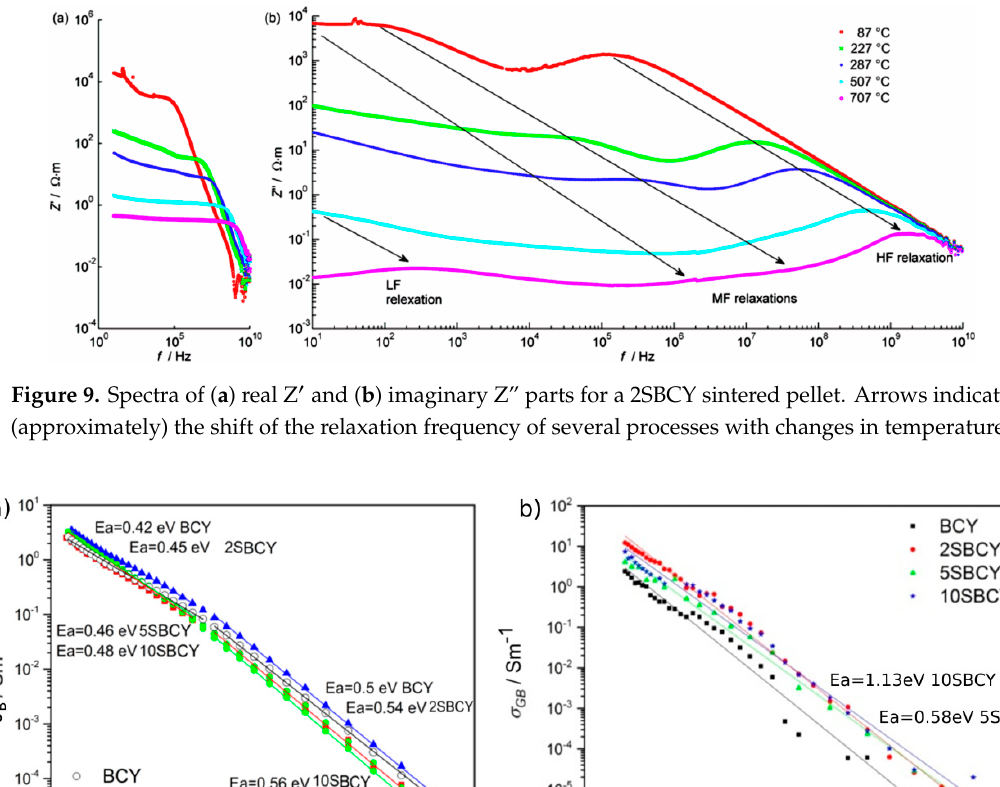
Figure 9. Spectra of ( a ) real Z ′ and ( b ) imaginary Z ʺ parts for a 2SBCY sintered pellet. Arrows indicate (approximately) the shift of the relaxation frequency of several processes with changes in temperature.